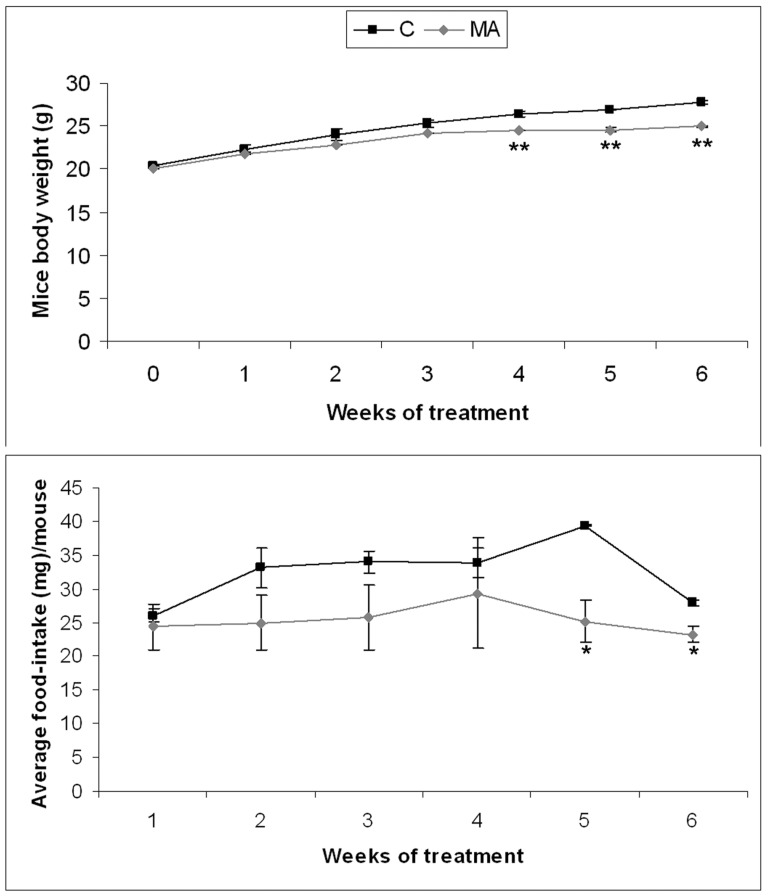
Body weight and diet consumption monitoring.A) Effects of MA treatment on body weight. B) Effects of MA feeding in food intake. Data represented as mean ± SEM (* *, p<0.01).